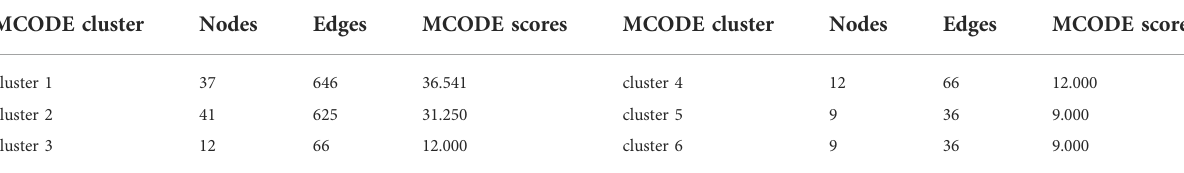
TABLE 1 The top six MCODE clusters in the PPI